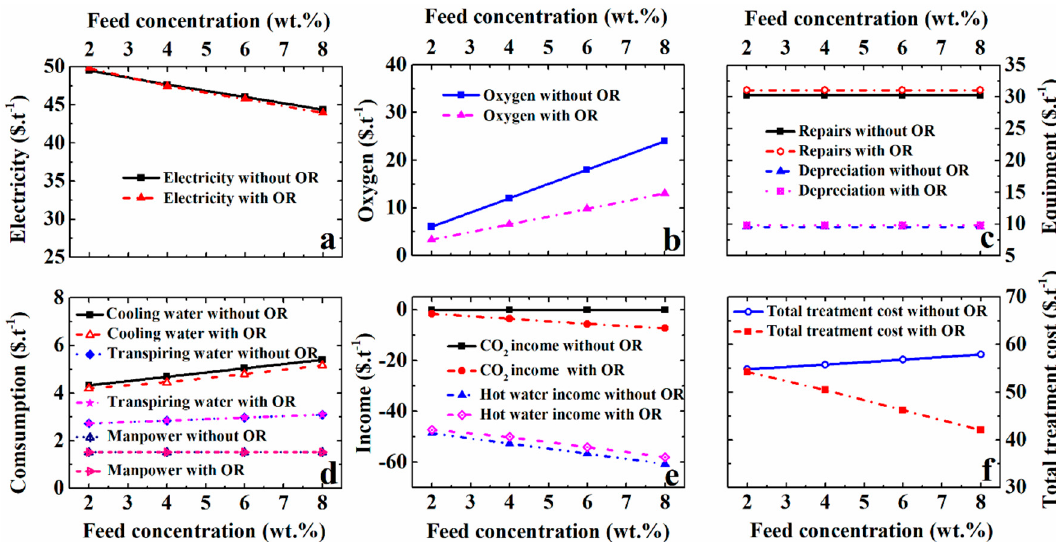
Figure 12. The effect of feed concentration on the treatment cost for a SCWO system with and without OR, ( a ) electricity consumption, ( b ) oxygen consumption, ( c ) equipment repairs and depreciation, ( d ) cooling water, transpiring water, and manpower consumption, ( e ) CO 2 and hot water income, and ( f ) total treatment cost.